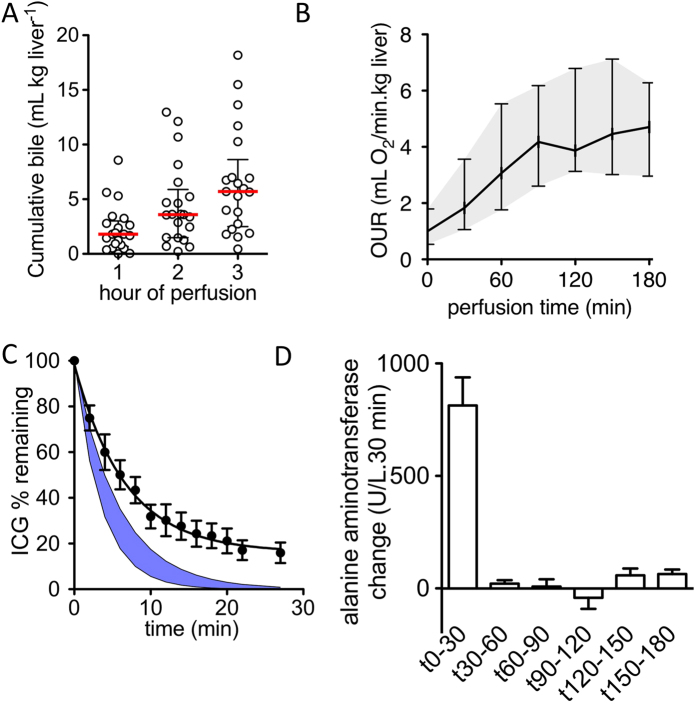
Characterization of function and injury.(A) Cumulative production of bile. Bile flow was measured hourly and was sustained for 3 hours of SNMP (n = 21, mean ± sem) (B) Oxygen uptake from the perfusate. The oxygen uptake rate calculated from in- and outflow partial oxygen (pO2) increased substantially during the first two hours of SNMP preservation (n = 21, mean ± sem (shaded)) (C) Clearance of indocyanine green (ICG). The postperfusion clearance of ICG was reduced from reference values (blue shaded) under ex vivo subnormothermic conditions (n = 7, mean ± sem (shaded)). (D) Release of alanine aminotransferase. Significant ALT release was observed in the first 30 minutes, after which release of ALT was reduced to a minimum for the remainder of the SNMP (n = 21).